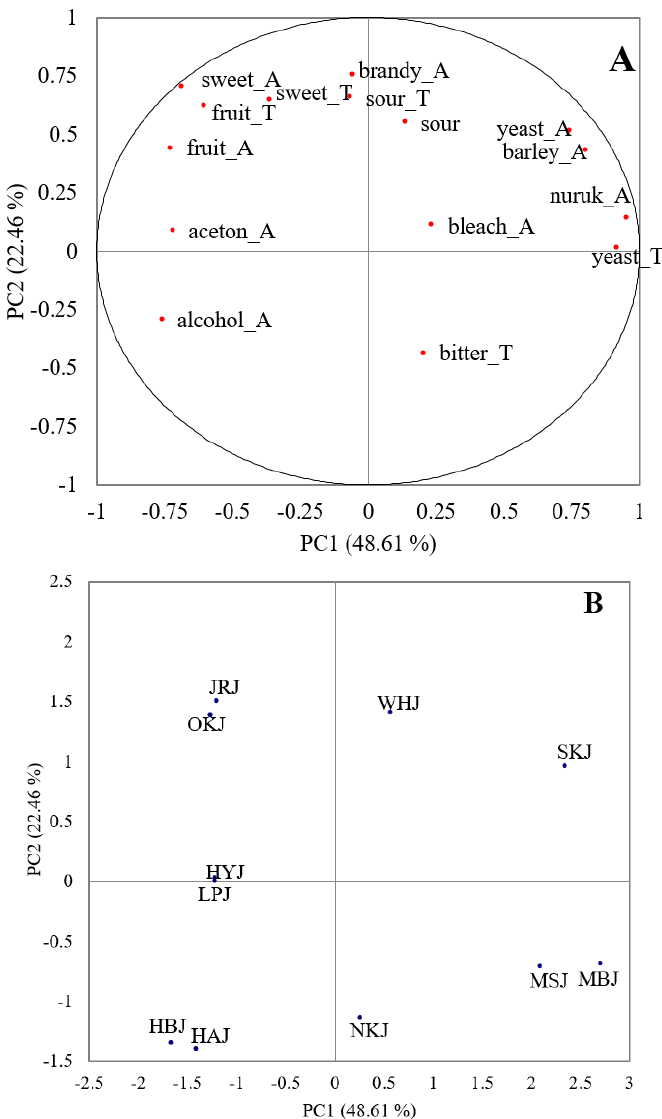
Figure 2. Principal component analysis loadings for 22 sensory attributes ( A ) and scores for the 11 distilled soju samples ( B ). The samples and sensory attribute codes are defined in Tables 1 and 2. PC1, first principal component; PC2, second principal